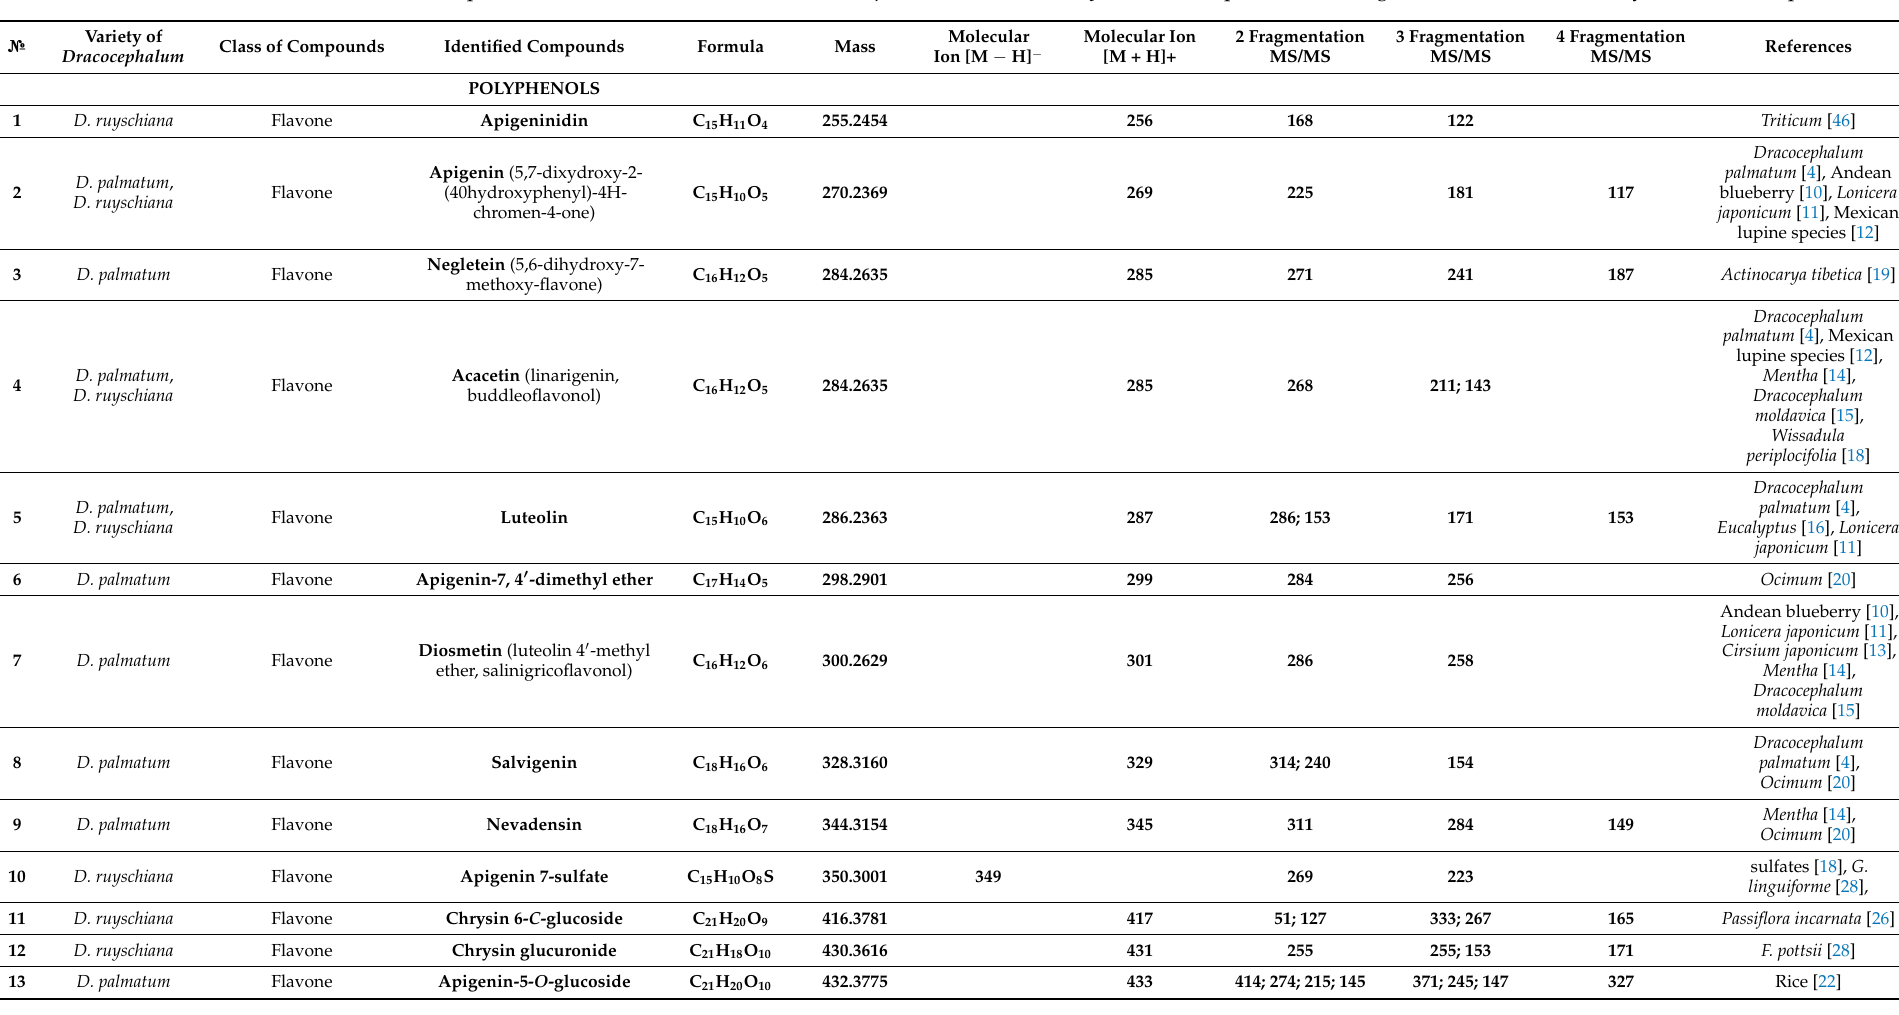
Table A1. Compounds identified from the extracts of D. palmatum S. and D. ruyschiana L. in positive and negative ionization modes by HPLC–ion